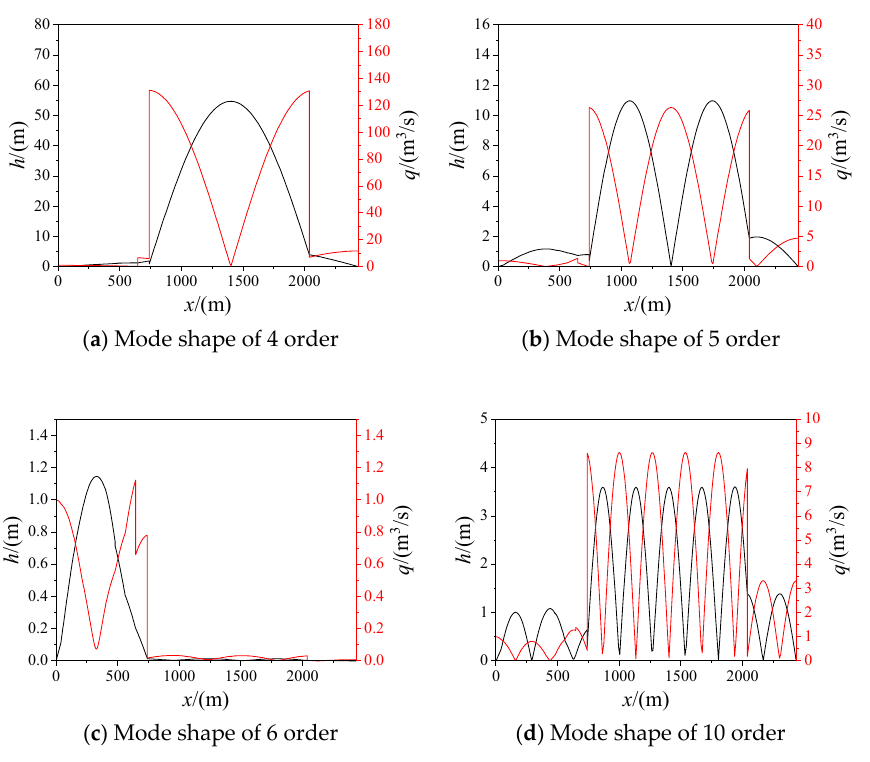
Figure 10. Vibration mode shapes.